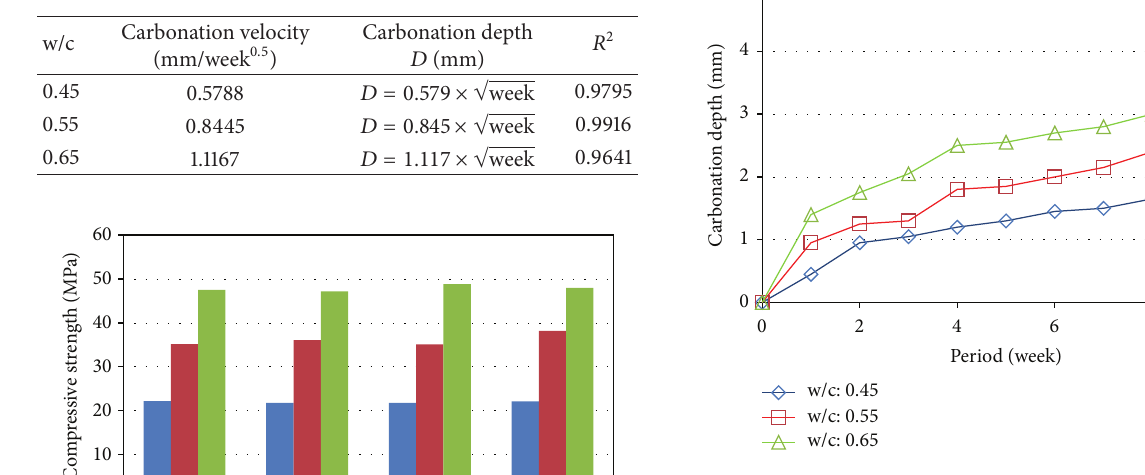
Figure 7: Carbonation depth with exposed